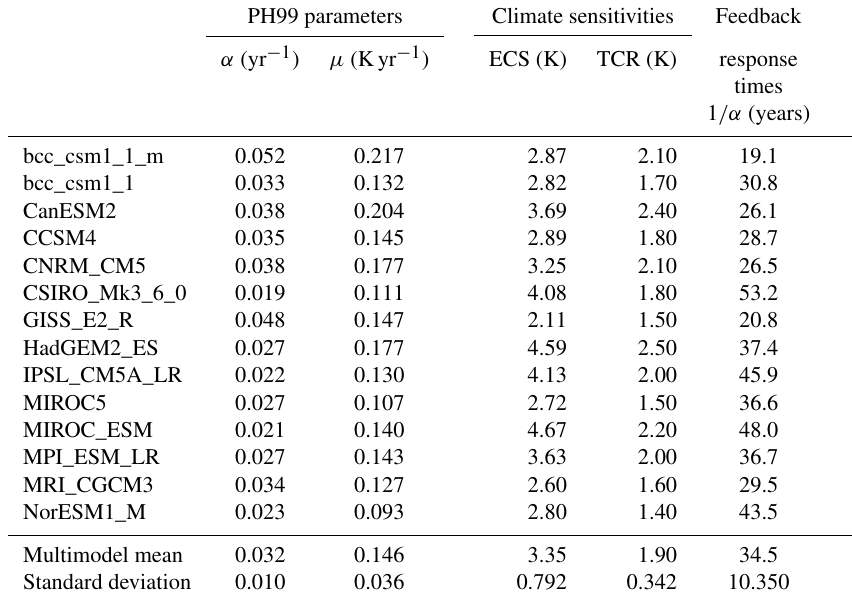
Table 1. PH99 parameters ( α and µ ) and feedback response times (1 /α ) utilizing data (ECS and TCR) from